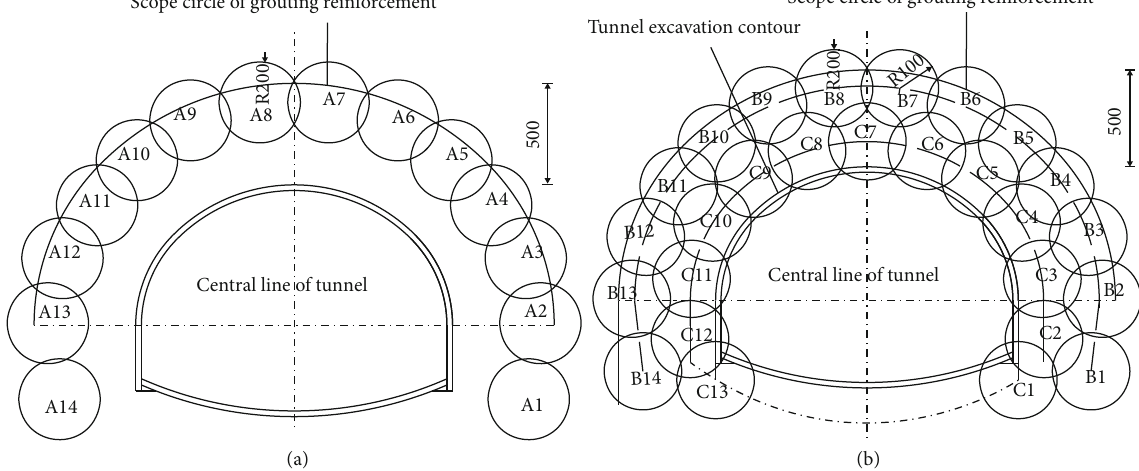
Figure 11: Schematic diagram of hole cross-circle: (a) the middle section; (b) the fi nal section (units: cm).